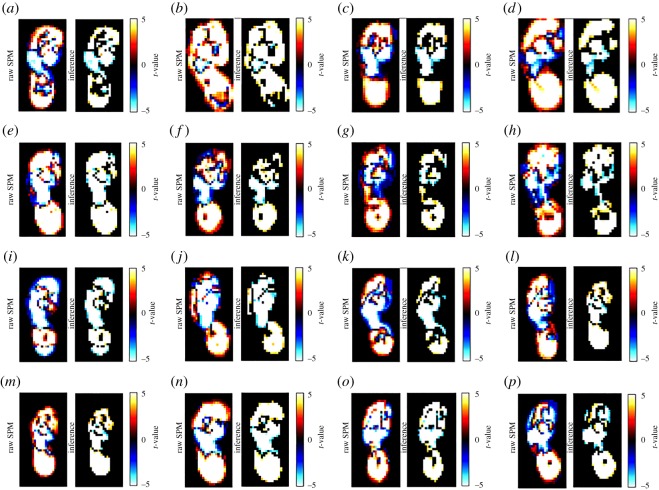
(a–p) Linear regression by pSPM (left panel) reveals no statistical support for linear changes in variability by m.s.e. with speed. The left image is the inference map, showing areas of increasing or decreasing variability in pressure across the plantar surface. The red pixels indicate that variability is increasing with speed around the periphery of the heel and forefoot only. The blue pixels indicate that variability is decreasing with speed around periphery of the midfoot and occasionally the hallux. Statistically significant pixels are concentrated almost exclusively around the periphery of mechanically distinct areas of the foot, thus they are most probably artefacts of small changes in foot contact area, size and shape with speed. The mechanically distinct areas of the plantar surface, heel, mid- and forefoot, remain white with no statistically significant relationships evident between variability and speed.